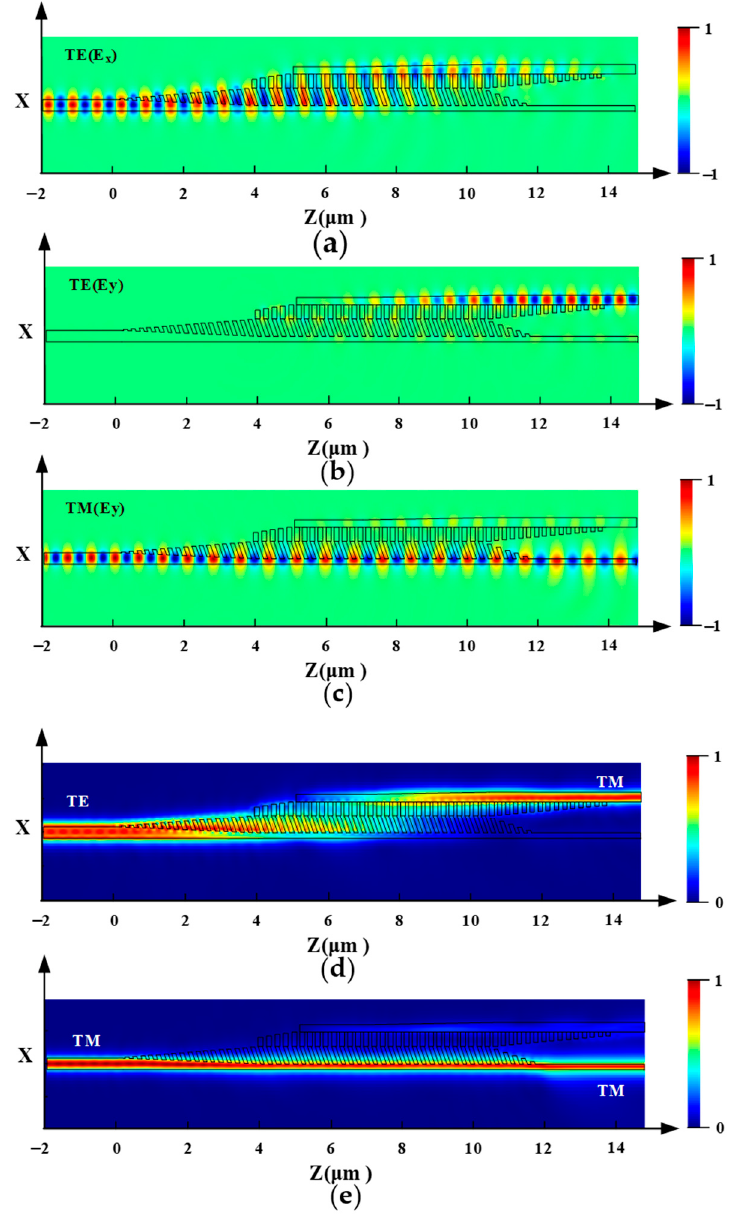
Figure 7. Mode evolution of ( a ) the E x and ( b ) E y for the fundamental TE mode, and ( c ) E y for the fundamental TM mode with the optimal parameter. Light intensity of ( d ) the input TE and ( e ) TM modes through the proposed PSR.